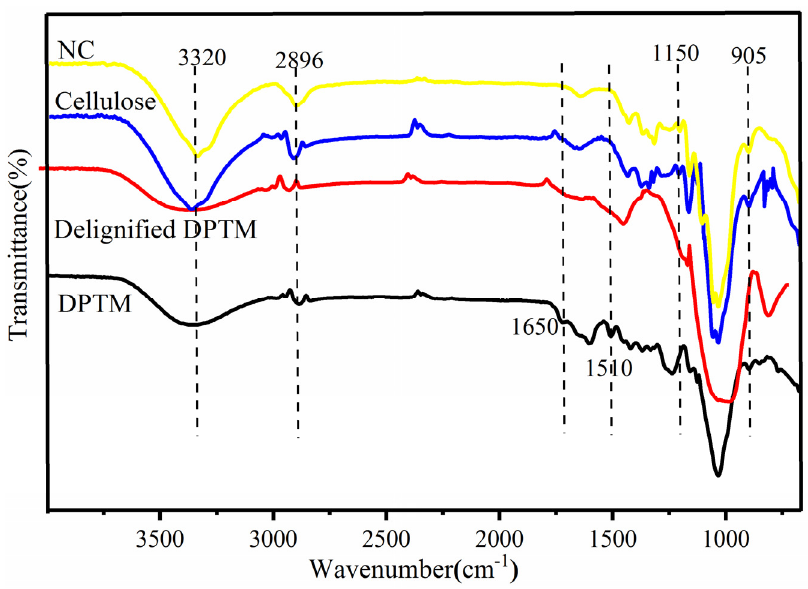
Figure 2. FTIR spectra of DPTM, delignified DPTM, cellulose and nanocellulose samples.